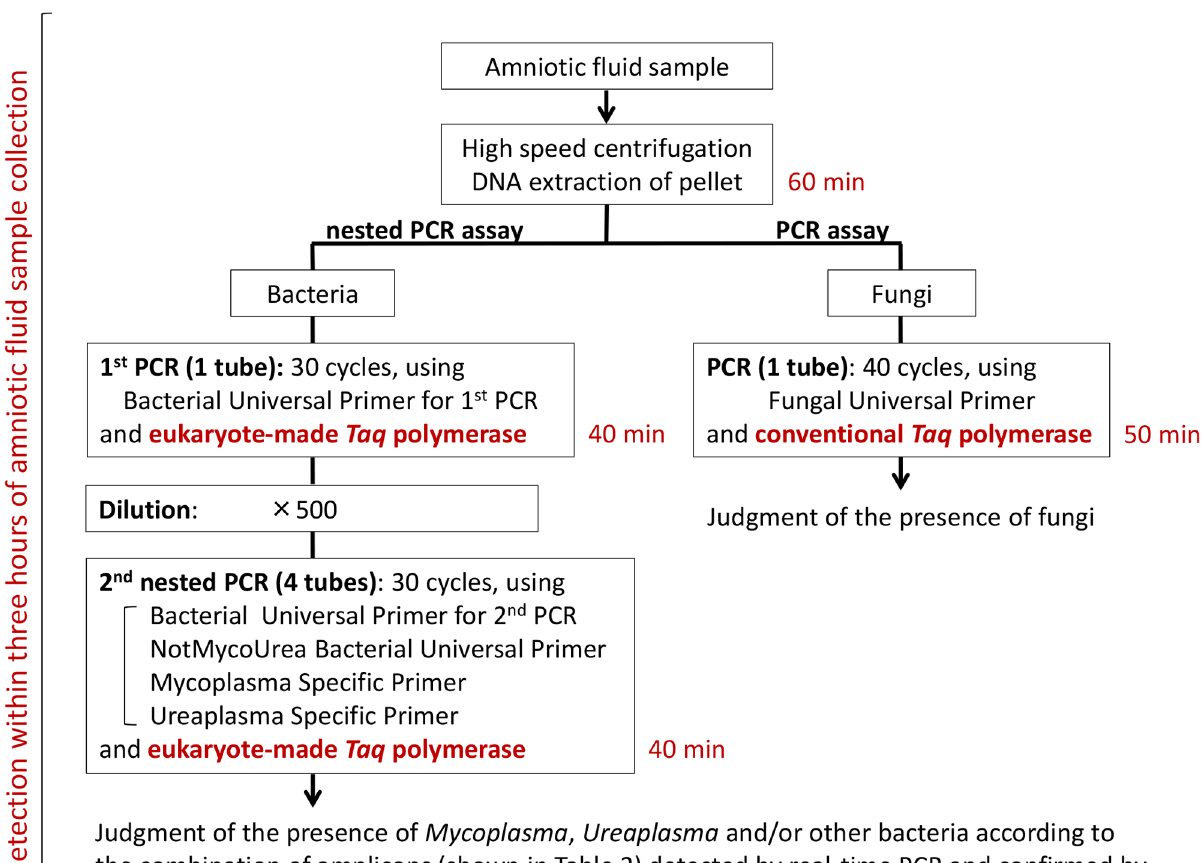
Fig 1. The workflow of the rapid detection method for Mycoplasma , Ureaplasma , other bacteria and fungi in amniotic fluid samples. Using this PCR-based method, pathogens can be detected within three hours of amniotic fluid sample collection. To prevent the occurrence of unreliable results in PCR-based assaying of amniotic samples for bacterial pathogens, eukaryote-made thermostable DNA polymerase (or Taq polymerase), which is free from bacterial DNA contamination, is used in combination with bacterial universal primers (along with two specific primers in the second, nested PCR). In contrast, for fungal pathogens, conventional bacterially-made thermostable DNA polymerase (or Taq polymerase), which is usually free from fungal DNA contamination, is used in combination with fungal universal primers.